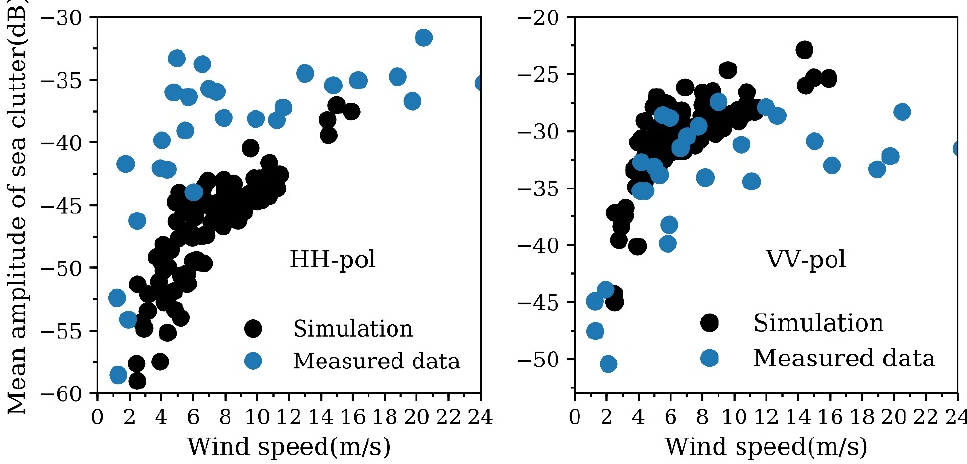
Figure 11. Comparison of X-band-simulated data and radar-measured data in the Yellow Sea. Figure 12 shows the estimated K distribution [30], Pareto distribution [31] and Weibull distribution [32] of the simulated data under different sea conditions and polarizations in the X-band. The normalized scattering coefficient amplitude is obtained by dividing by the data mean, and the number of samples in the amplitude mean data is 1024. It can be seen that both the K distribution and the P distribution can well estimate the distribution of the simulation data. The tailing phenomenon of sea clutter data is more serious under high-frequency and high-sea conditions, especially the HH